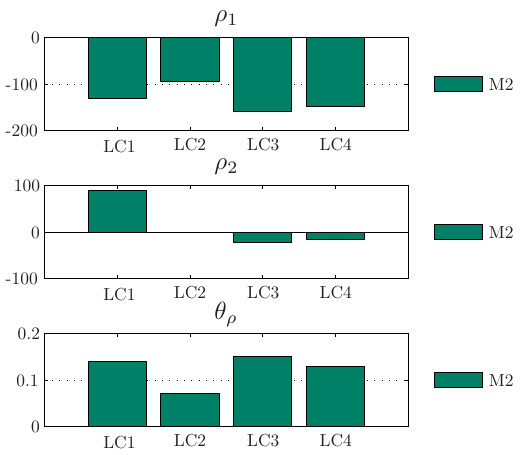
Figure 11: Comparison of